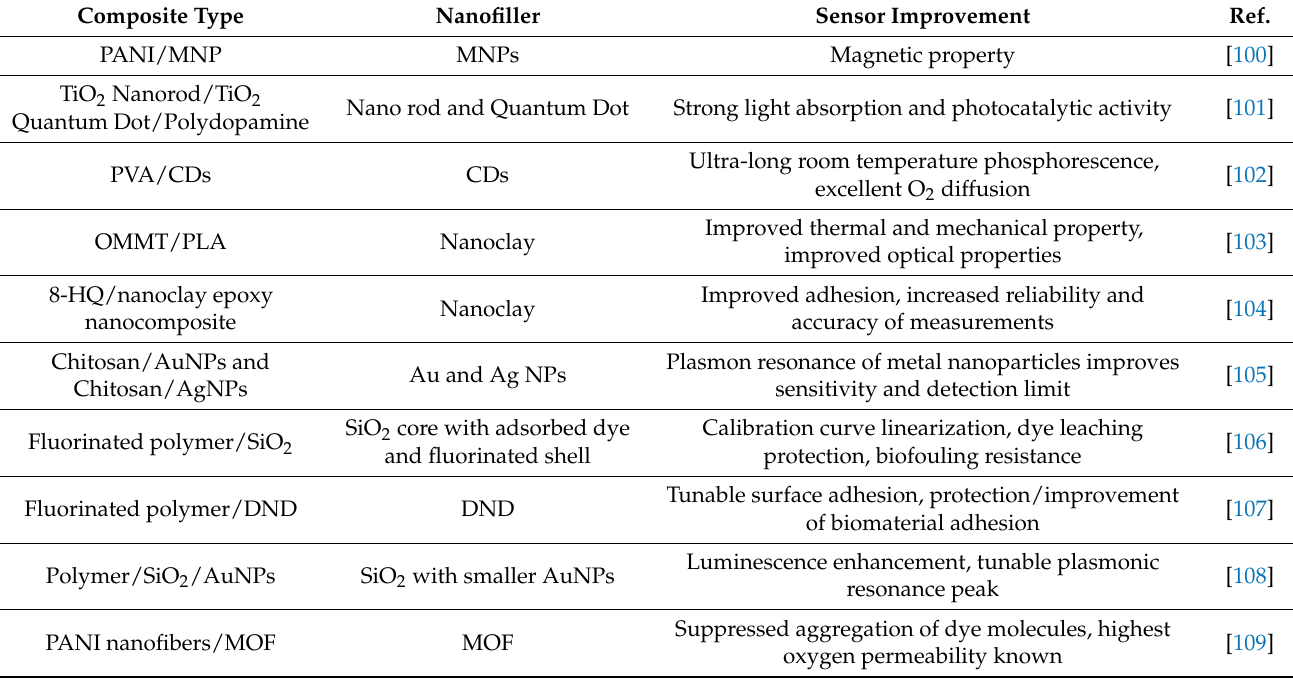
Table 1. Improvement of the properties of polymer nanocomposites and sensors due to the influence of some